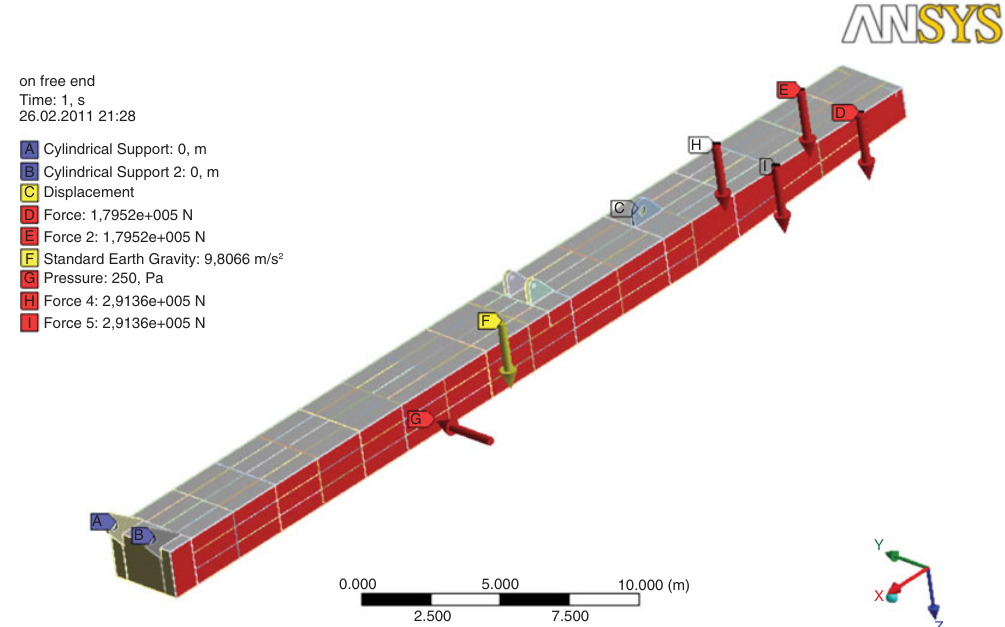
Fig. 7. Trolley with container is at the end of console (boundary conditions)